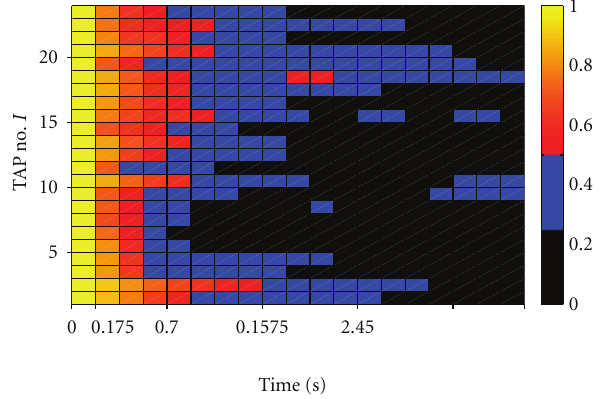
Figure 7: Example of the auto-correlation coe ffi cient in the time domain. All those auto-correlations are similar. After 1.575 sec, the correlations become insignificant (below 0.5).